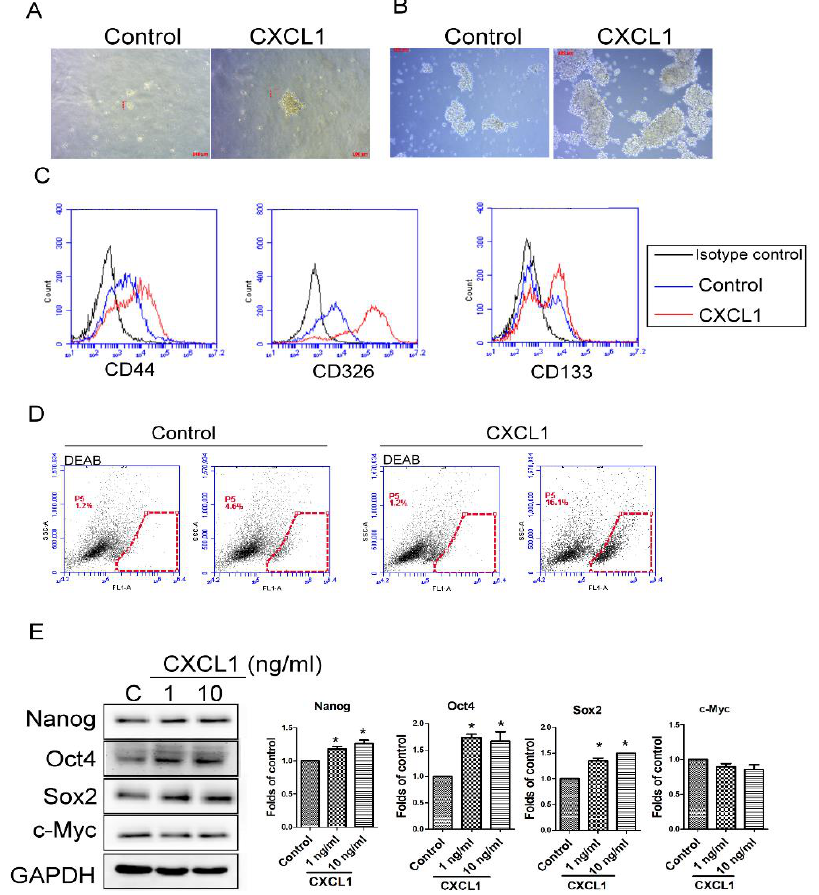
Figure 3. CXCL1 increased cancer stem cell (CSC) properties in SW620 colon cancer cells. Anchorage-independent growth ( A ) and tumor spheroid formation ( B ) of CXCL1-treated SW620 cells. The expression of CD44, CD326 and CD133 ( C ) and aldehyde dehydrogenase (ALDH) activity ( D ) in tumor spheroids. SW620 cells were cultured with CXCL1 protein in soft agar (0.4%) or ultra-low attachment wells for 40 and 10 days, respectively. The tumor spheroids were counted by microscope. ALDH activity and surface markers of tumor spheroids were determined by ALDEFLUOR assay and flow cytometry. ( E ) Level of CSC-related transcription factors in tumor spheroids. Results are representative of at least three independent experiments. Each value is the mean ± SD of three determinations. * Significant difference between the two test groups ( p < 0.05) (*).